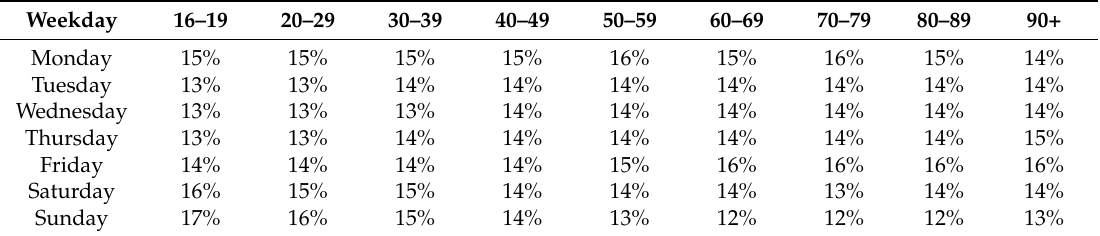
Table 4. Percentage distribution of age group, by weekday of visit ( N = 264,272 persons).